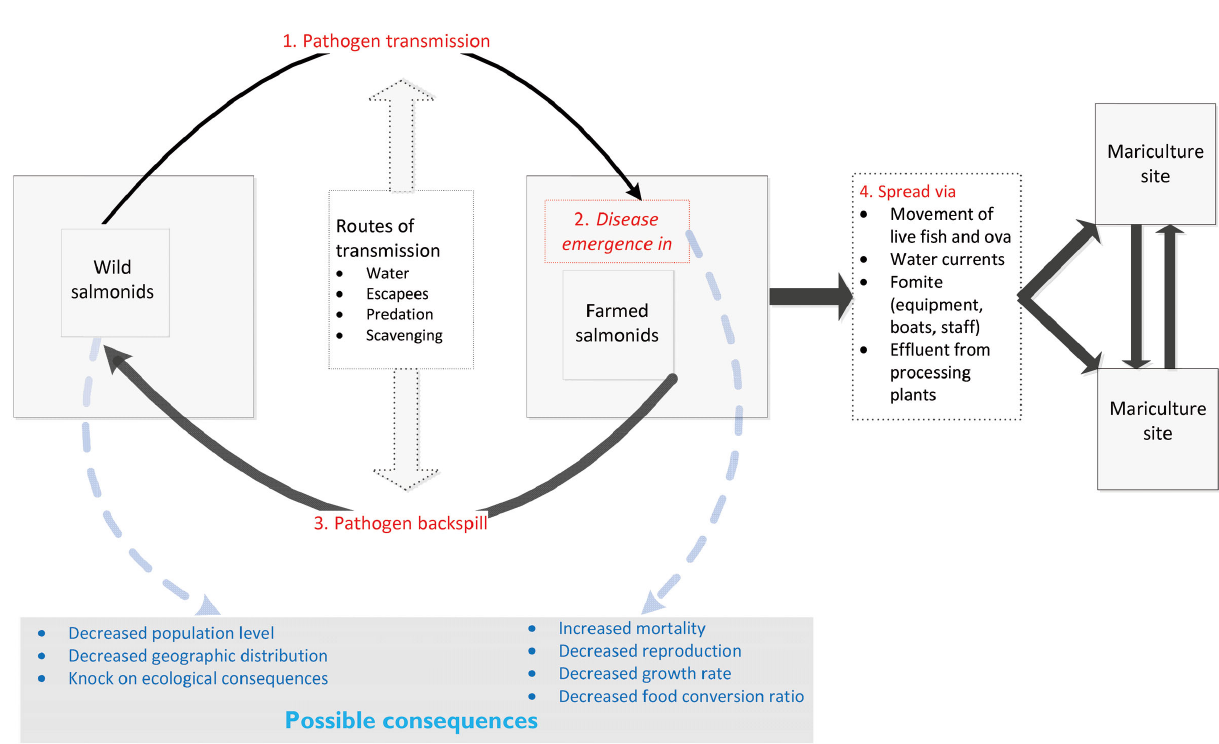
Fig. 1. Routes and consequences of pathogen interactions between farmed and wild salmonids (numbers indicate temporal sequence of processes driving emergences: 3. and 4. may occur simultaneously)